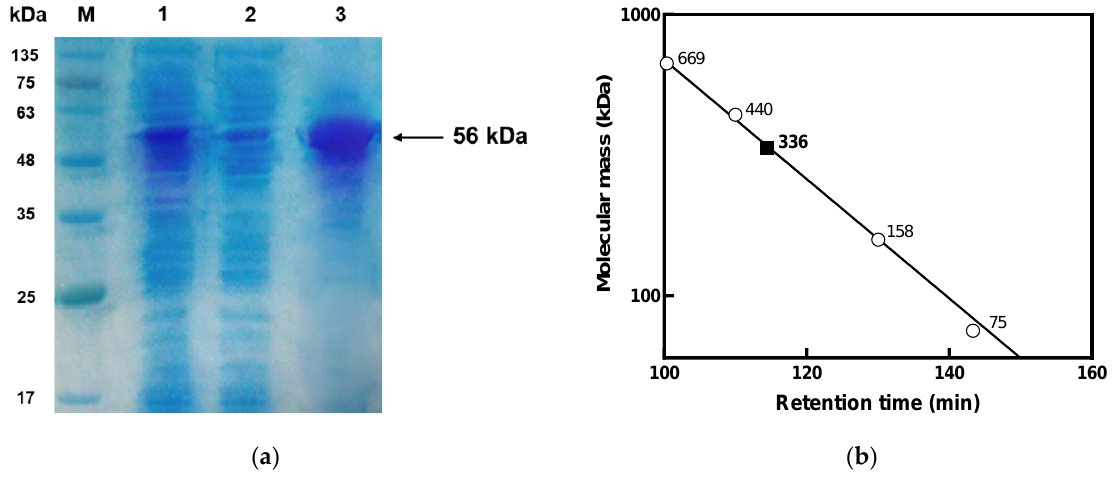
Figure 1. SDS-PAGE and gel filtration analyses of L -arabinose isomerase from K. pneumoniae . ( a ) SDS-PAGE of L -arabinose isomerase from K. pneumoniae . M, molecular weight size marker proteins; lane 1, pellet; lane 2, crude enzyme extract; and lane 3, purified L -arabinose isomerase from K. pneumoniae. ( b ) Gel filtration chromatography of L -arabinose isomerase from K. pneumoniae . The solution of purified L -arabinose isomerase from K. pneumoniae (filled square) was applied to a Sephacryl column. The column was calibrated using the reference proteins (empty circle) conalbumin, aldolase, ferritin, and thyroglobulin, corresponding to 75, 158, 400, and 669 kDa, respectively.